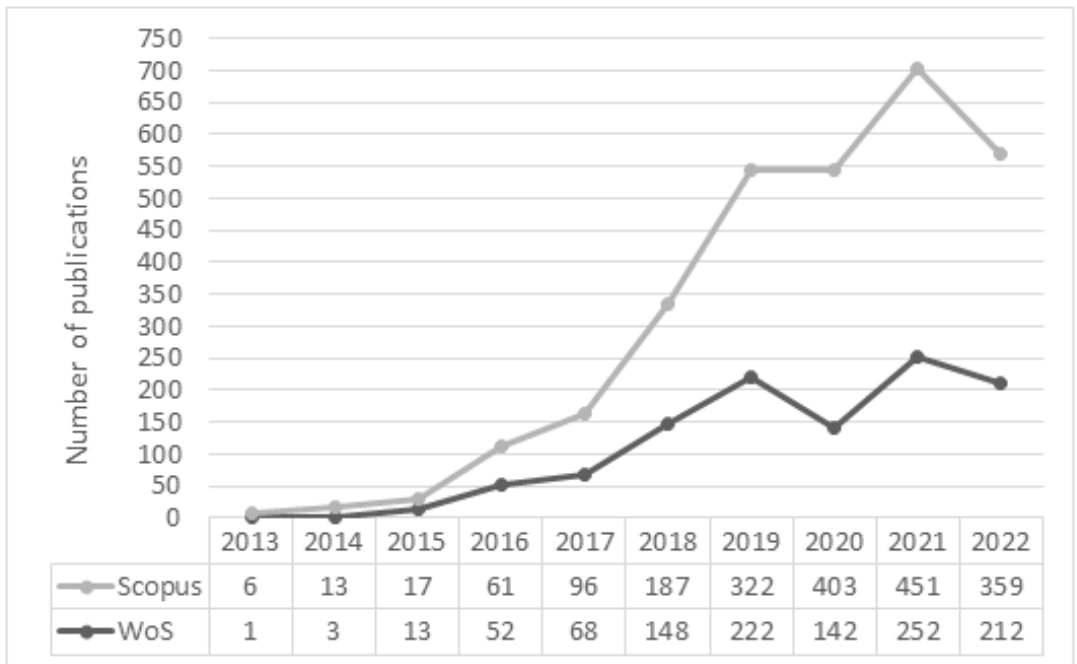
Figure 10. Publications in engineering disciplines from 2013–2022 that included the term Maintenance 4.0 and were published in Scopus and Web of Science databases.